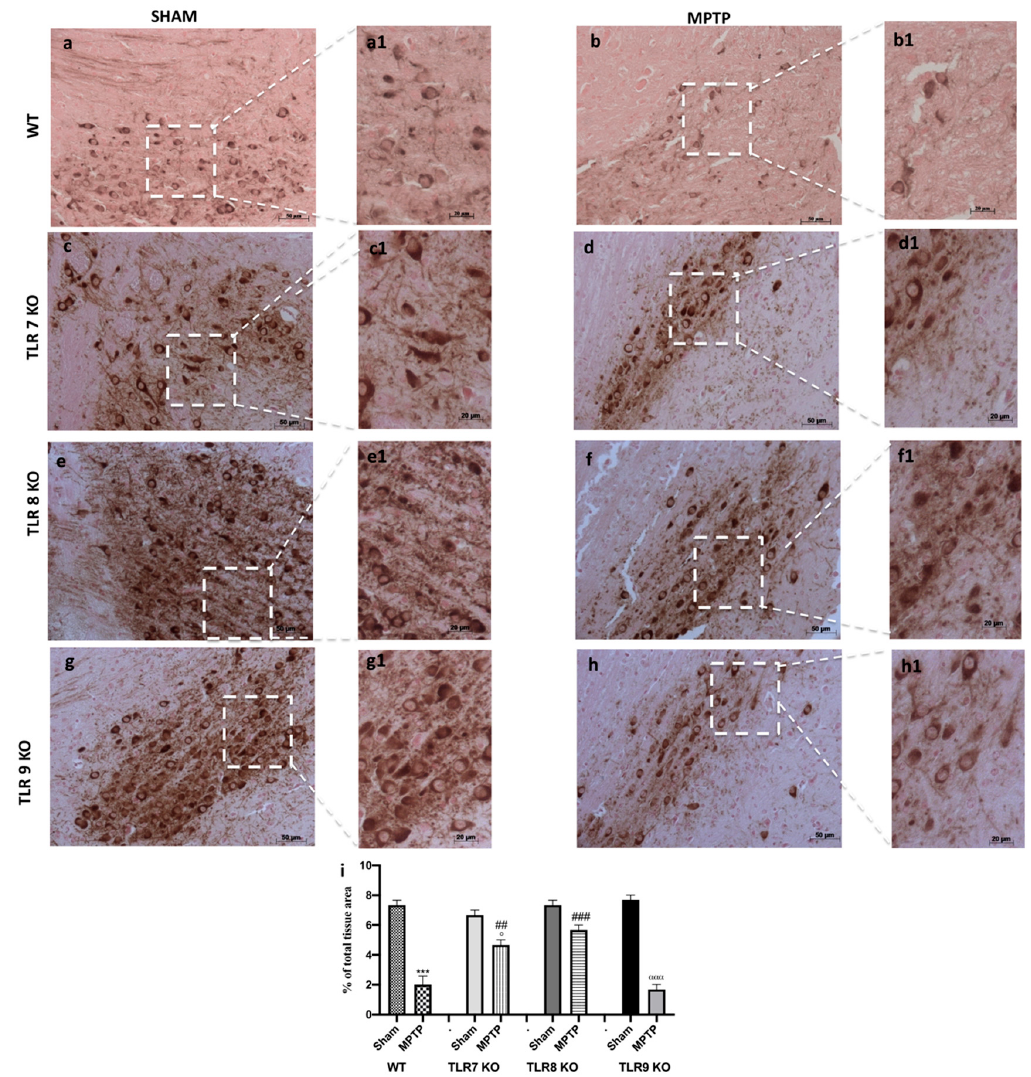
Figure 3. E ff ect of TLR 7, 8, and 9 on TH immunoreactivity. By immunohistochemistry, we observed a TH immunoreactivity. WT mice MTPT-injected ( b , b1 ) revealed a significant decrease of TH + neurons compared to SHAM WT ( a , a1 ). In TLR7 and 8 KO mice the reduction of DA neurons was significantly preserved ( d , d1 , f , f1 , respectively), compared to, respectively, SHAM groups ( c , c1 , e , e1 , respectively), while, in TLR 9 KO mice subject to MPTP, there was a reduction of TH positive cells ( h , h1 ) compared to TLR9 SHAM ( g , g1 ). Panel A and B showed WT mice. See densitometric analysis ( i ). Data are means ± SEM of 10 mice for each group. *** p < 0.001 vs. SHAM WT ◦ p < 0.05 vs. SHAM TLR7 KO; ααα p < 0.001 vs. SHAM TLR9 KO; ### p < 0.001 vs. MTPT WT and ## p < 0.01 vs. MTPT